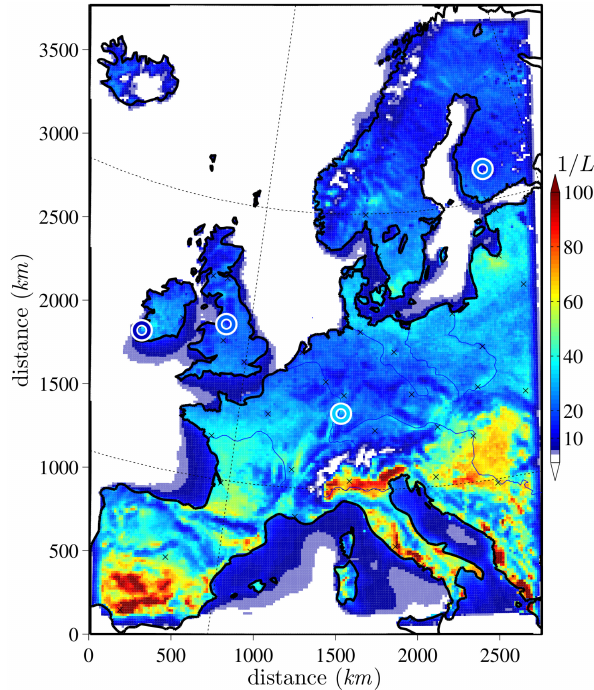
Figure 10. Horizontally distributed FBAP/fungal spore concentra- tion in 1L − 1 , emitted by F FBAP , in the lowest model layer, aver- aged from 26 August to 1 September 2010 (excluding a spin-up period of 6h). Circles indicate the locations of the different FBAP measurement time series and the color within the white circles rep- resents the mean FBAP number concentration measured at each lo- cation.